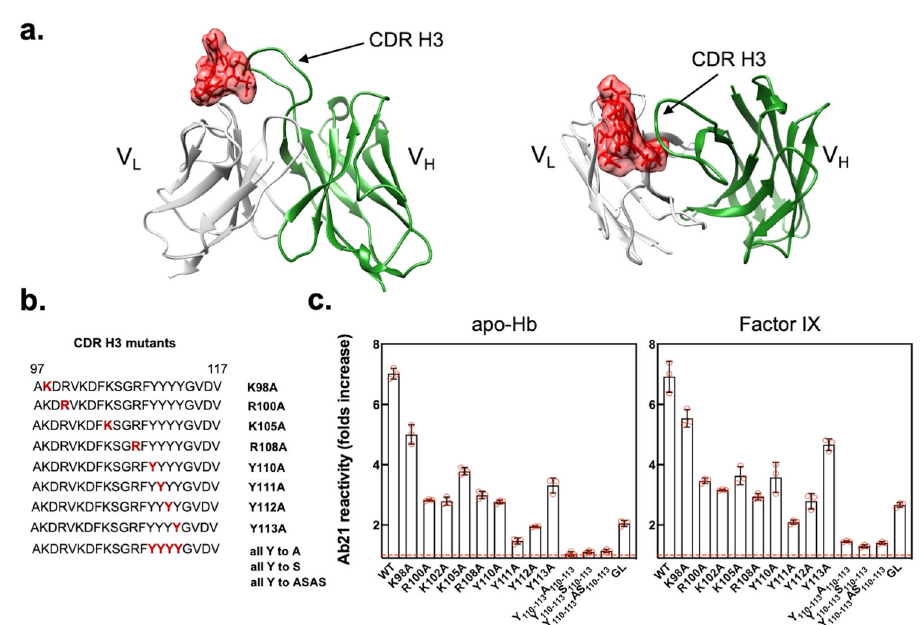
Fig. 5 Molecular features of antigen binding site of a monoclonal IgG acquiring polyreactivity and autoreactivity after exposure to metHb. a Structural model of the complex of variable region of Ab21 and heme. The picture was generated using data from structural modeling of Ab21 variable region and molecular docking that were already published in ref. 60 . Light chain variable domain is depicted in gray, heavy chain variable domain is depicted in green. Protoporphyrin IX ring (used for the docking) was depicted in red. Side and top views of the variable region are shown. The models were built using UCSF Chimera software v. 1.16. b A plot depicting the sequence of CDR H3 of Ab21 and the residues that were mutated (highlighted in red). The individual mutants are listed on right. c Immunoreactivity of Ab21 mutants towards human factor IX and human apo-Hb. Ab21 wt, its mutants and its germline variant (GL) were diluted to 1 μ M and incubated with 0.16 μ M metHb. After, all samples were diluted 10 folds and incubated with the immobilized antigens. The plots depict the ratio of binding of each antibody variant after treatment with metHb versus the binding of the Ab21 in the absence of treatment (background reactivity). The red dashed line indicates the ratio of 1 corresponding to absence of effect of metHb. Each bar represents mean ratio ±SD from n = 3 repetitions of each sample. The individual values are presented in red